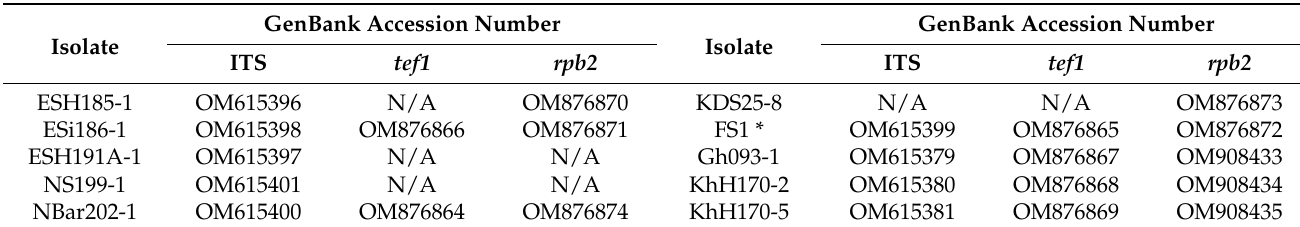
Table 3. List of Stilbocrea banihashemiana sp. nov. and their GenBank accession